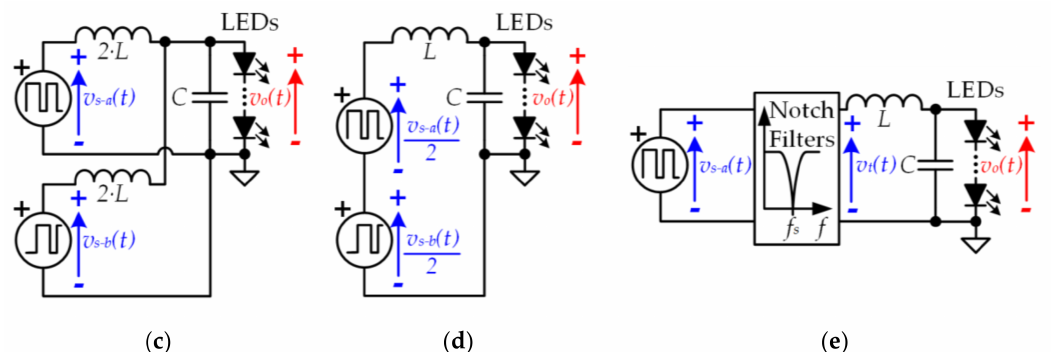
Figure 13. ( a ) Two-phase buck converter; ( b ) Equivalent circuit considering the two possible operating states; ( c ) Equivalent circuit considering two pulse-width modulators; ( d ) Equivalent circuit obtained by applying the superposition and Thevenin’s theorem to the capacitor terminals; ( e ) Equivalent circuit considering H ( f ).